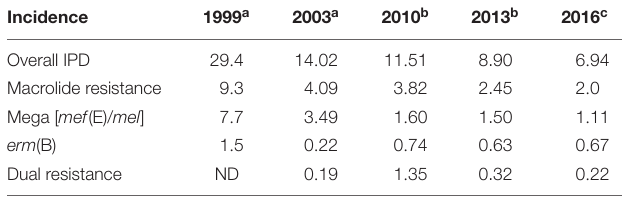
TABLE 3 | Incidence of macrolide-resistant invasive pneumococcal disease (MR-IPD) 1999–2016 in Health District-3, Atlanta, GA, by macrolide resistance genotype across all